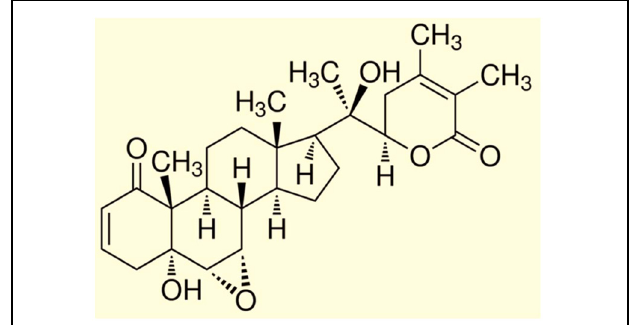
FIGURE 2 | Chemical structure of Withanolide A. [Reproduced with permission from Kurapati et al. (2014).]